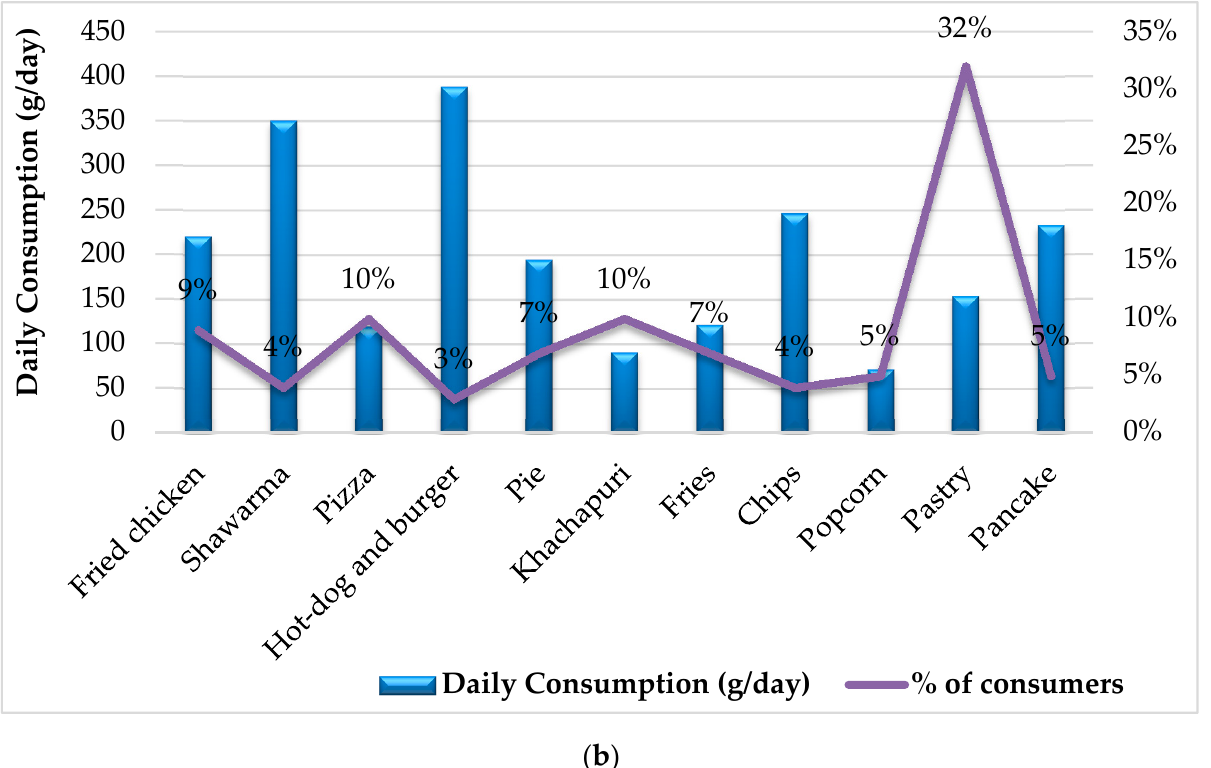
Figure 3. Daily Consumption (g/day) of Fast-Food for Cluster 1 ( a ) and Cluster 2 ( b ).